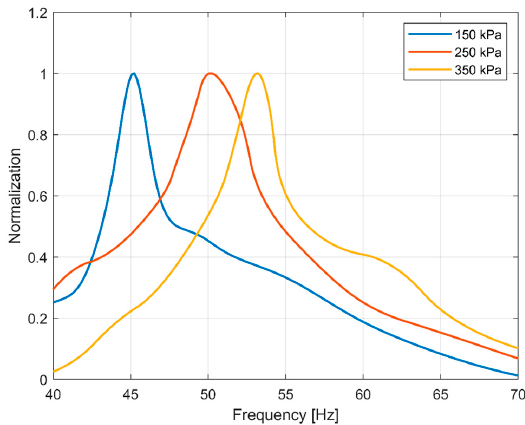
Figure 10. Weighted amplitude-frequency curves at different tire pressures.